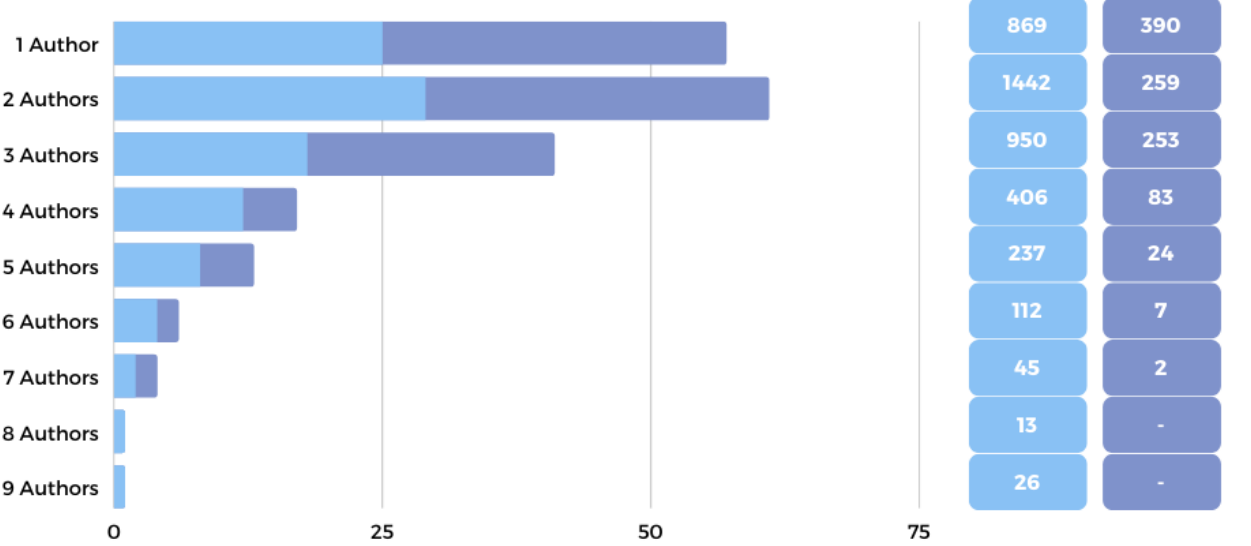
Figure 7. Distribution of articles and citations by number of authors in Scopus and WoS. Source: Authors’ own data .